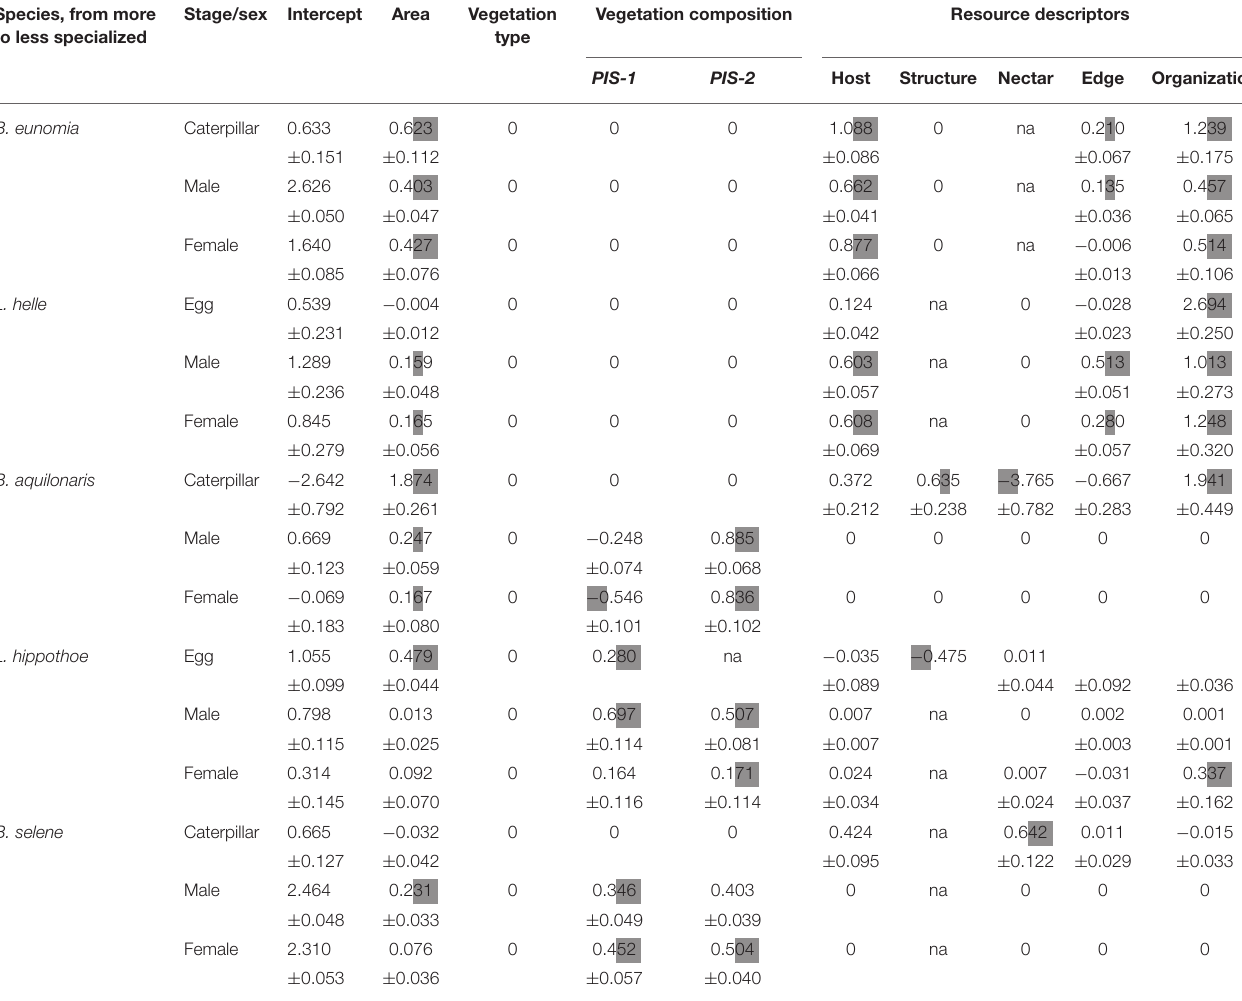
TABLE 2 | Relationship between local species abundance and habitat descriptors represented by slope estimates of linear models. Species, from more to less